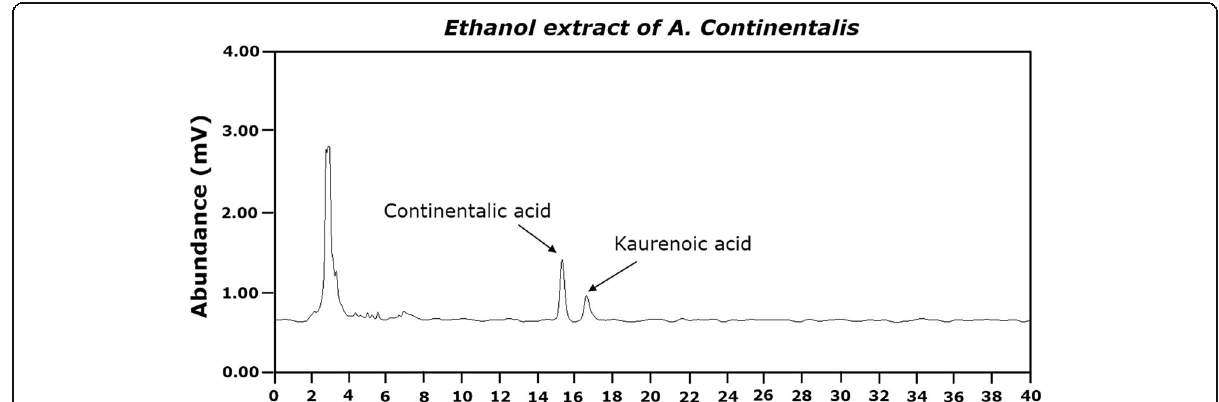
Fig. 1 High performance liquid chromatography (HPLC) chromatogram of AC. Phytochemical analysis was performed using HPLC as described in the Materials and Methods section. Authentic standard of continentalic acid (7-oxo-ent-pimara-8,15-diene-19-oic acid) and kaurenoic acid (en- kaura-16-en-19-oic-acid) were used, and their contents in the AC extract were determined to be 12.097 ± 0.200 and 3.378 ± 0.253 mg/g extract,